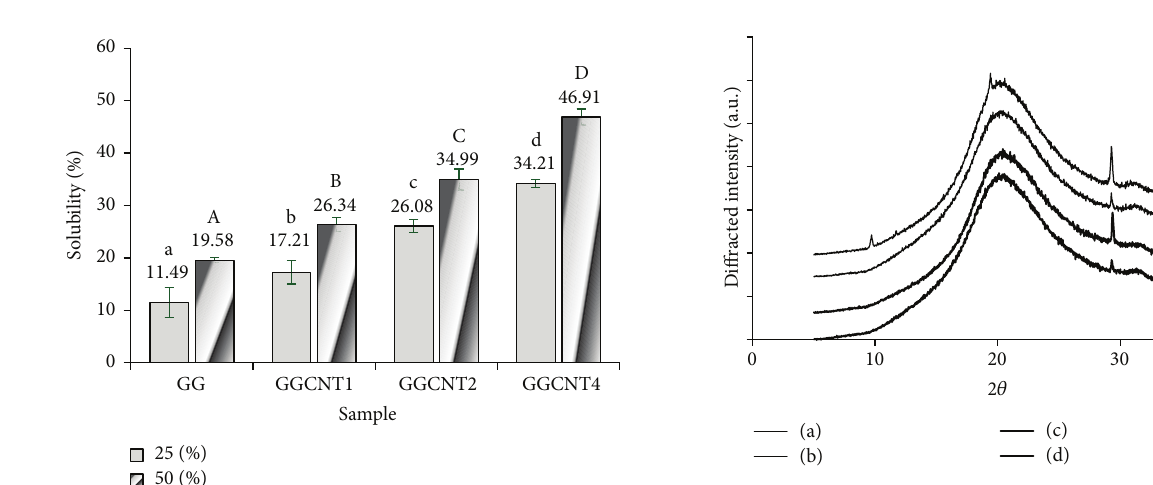
Figure 1: Solubility of films from gelatin/glycerol and carbon nanotubes, at 25 ∘ C and 80 ∘ C. Error bars with the same letter are not significantly different ( 𝑃 > 0.05 ).